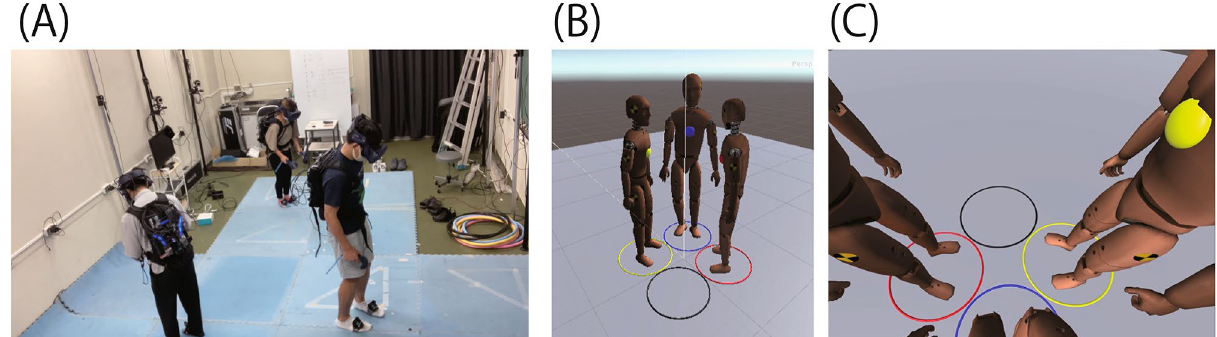
Figure 2. Work space of triadic jumping constructed in the virtual space. ( A ) Three jumpers in the laboratory immersing into the virtual triadic jumping space. Each was assigned a separate place so that they do not collide into each other. ( B ) Bird’s eye view of triadic jumpers used by an experimenter to check for collisions among the jumpers. Collision may occur only in the virtual space and cannot be confirmed in the real laboratory space. ( C ) Sight of a jumper (blue in the example) through the head-mounted display seeing the center of the square configuration of the 4-hoop